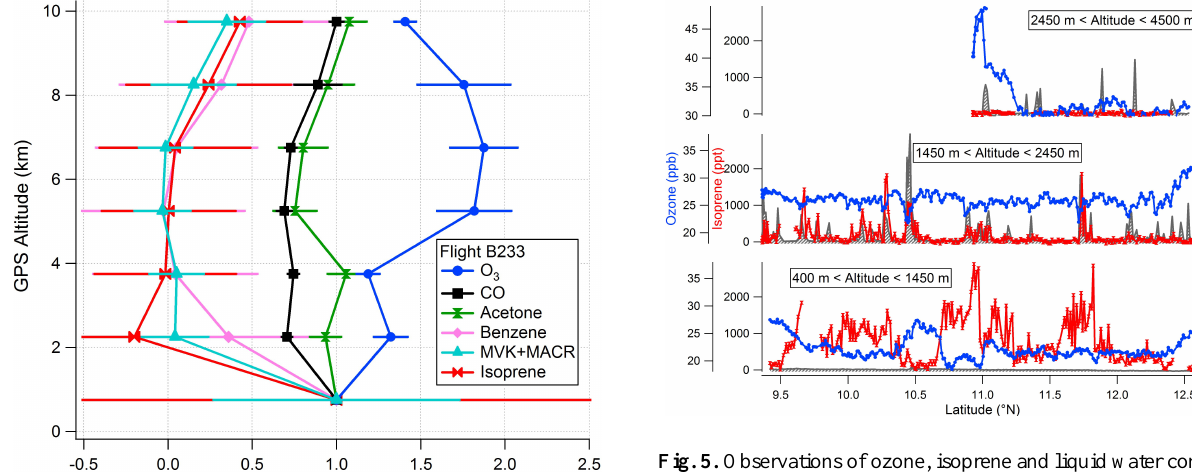
Fig. 5. Observations of ozone, isoprene and liquid water content on Flight B235 during a series of stacked runs at three different levels over a forested area in Benin. Note change in ozone scale in upper